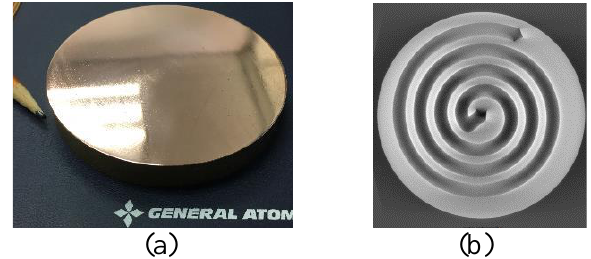
Fig. 14. 3D-printed copper mirror for a 63.5 mm miter bend (a), and X-ray image of spiral-shaped internal cooling channel